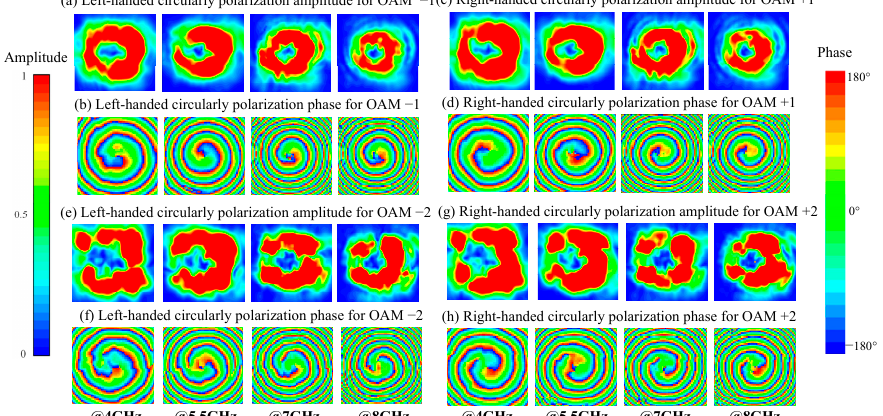
Figure 7. Measured near field distribution of the reflected beams: ( a ) LHCP amplitude and ( b ) phase for OAM − 1. ( c ) RHCP amplitude and ( d ) phase for OAM +1. ( e ) LHCP amplitude and ( f ) phase for for OAM − 1. ( c ) RHCP amplitude and ( d ) phase for OAM + 1. ( e ) LHCP amplitude and ( f ) phase OAM − 2. ( g ) RHCP amplitude and ( h ) phase for OAM +2. for OAM − 2. ( g ) RHCP amplitude and ( h ) phase for OAM + 2.